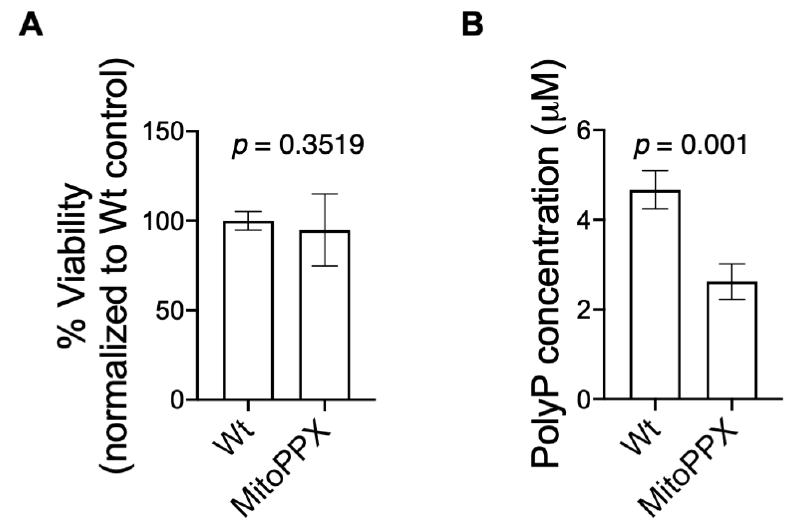
Figure 1. Mitochondria isolated from MitoPPX cells show decreased levels of polyP. However, the enzymatical depletion of the polymer within the organelle does not have a deleterious effect on cell viability in HEK293 cells. ( A ) Graph showing the results of the MTT cell viability assays. Note that no significant differences in terms of cell viability were found between Wt and MitoPPX cells in this experiment. ( B ) Graph showing the concentration of polyP in mitochondria isolated from Wt and MitoPPX cells. To demonstrate the decreased levels of the polymer in mitochondria isolated from MitoPPX cells, polyP was measured using DAPI fluorescence after the isolation of the organelles. PolyP concentrations were determined based on extrapolation from the standard curve, which was prepared with exogenous polyP. Data in the graph are shown as mean ± standard deviation of triplicates obtained from at least three independent experiments ( n = 3). Unpaired t-tests were used to detect significant differences between Wt and MitoPPX cells. Abbreviations used in this figure: MitoPPX: cells expressing the exopolyphosphatase enzyme in mitochondria; Wt: Wild-type cells; PolyP: inorganic polyphosphate, MTT: 3-(4,5-dimethylthiazol-2-yl)-2,5-dypheniyltretazolium bromide, DAPI: 4 (cid:48)